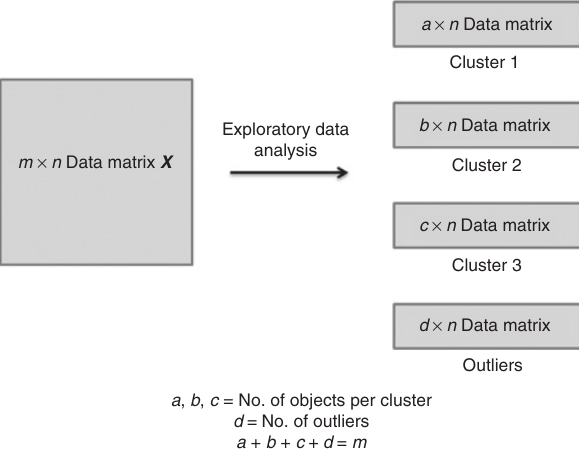
Figure 2: Visualization of the exploratory data analysis